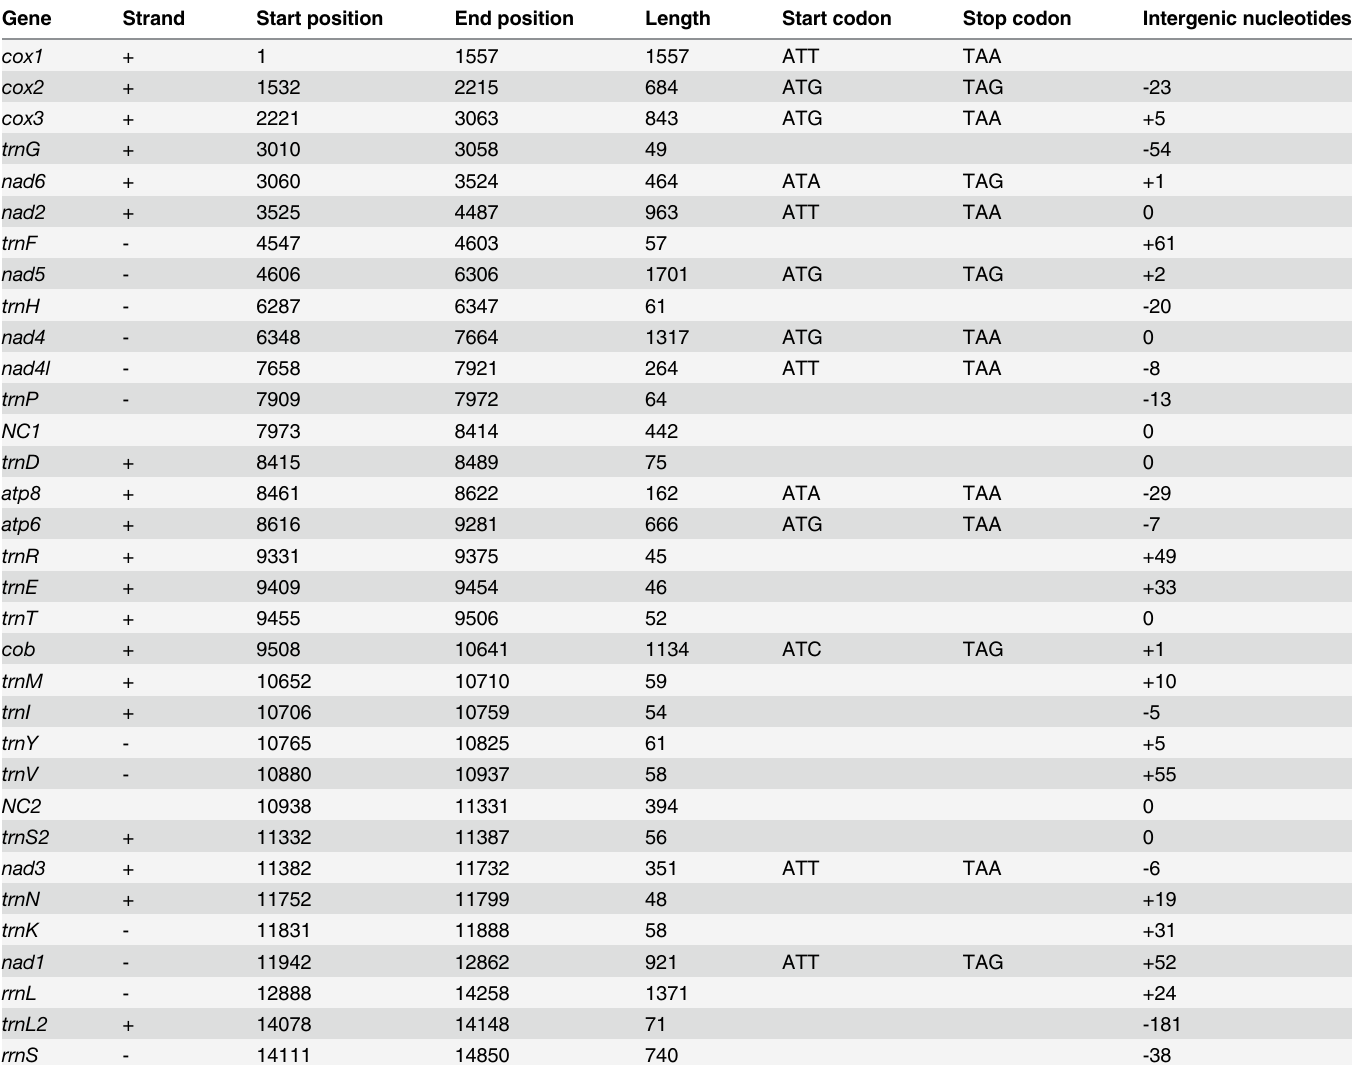
Table 1. Organisation of the Strigamia maritima mitochondrial